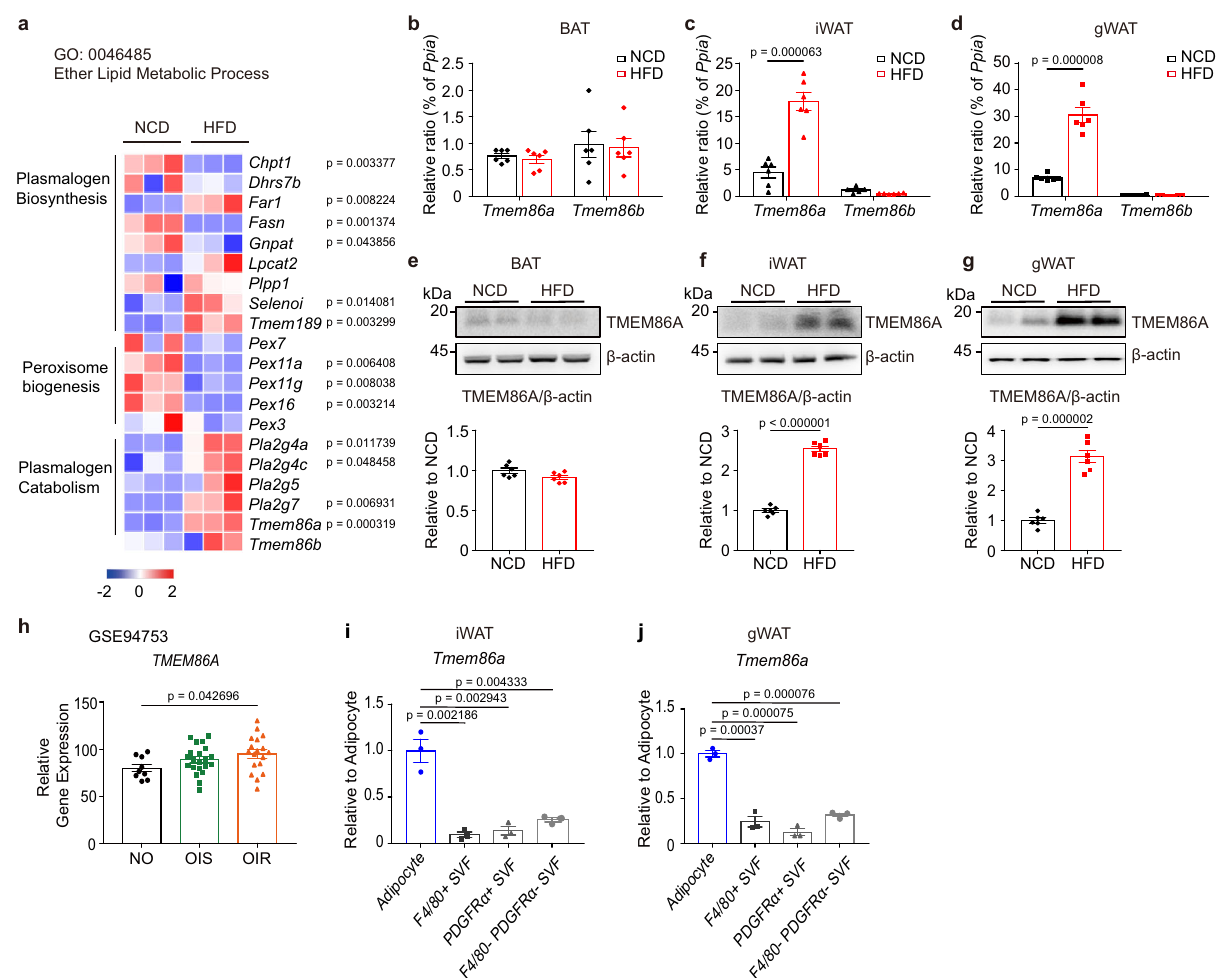
Fig. 1 TMEM86A is abundantly expressed in WAT and upregulated by HFD feeding. a Heatmap of RNA-seq data showing the effects of 8 weeks of high- fat diet (HFD) feeding on genes involved in ether lipid metabolism (GO: 0046485) in gWAT. (NCD: normal chow diet, *| fold change (FC) | > 2; p < 0.05) b – d qPCR analysis of Tmem86a and Tmem86b in BAT, iWAT and gWAT of mice fed a NCD or HFD for 8 weeks. n = 6. e – g Immunoblot analysis